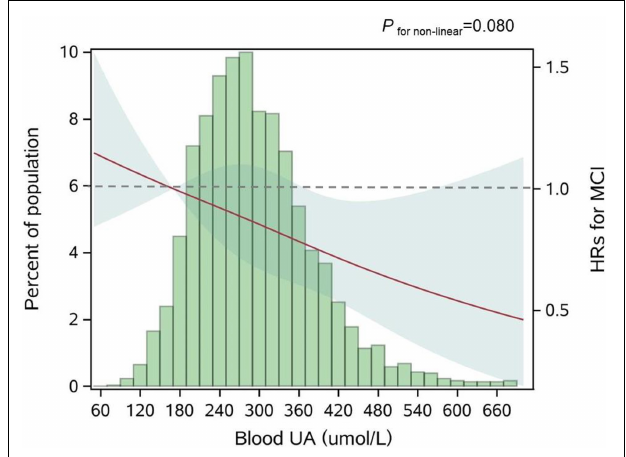
FIGURE 2 | Adjusted dose-response association between blood UA and risk for MCI. UA, uric acid; HR, hazard ratio; MCI, mild cognitive impairment. Blood UA was coded using a restricted cubic spline (RCS) function with three sex-specific knots, which approximately corresponded to the 5th (170.0 µ mol/L), 50th (281.6 µ mol/L), and 95th (454.3 µ mol/L) percentiles of blood UA distribution. The solid red line represents the adjusted hazard ratio for the risk of MCI for any value of UA compared to participants with 170.0 µ mol/L (P5) of blood UA level, with light green shaded areas showing 95% confidence intervals derived from restricted cubic spline regressions. The green histograms show the fraction of the population with the different levels of blood UA. The dashed gray line refers to the reference for the association at an HR of 1.0. P for non-linear =